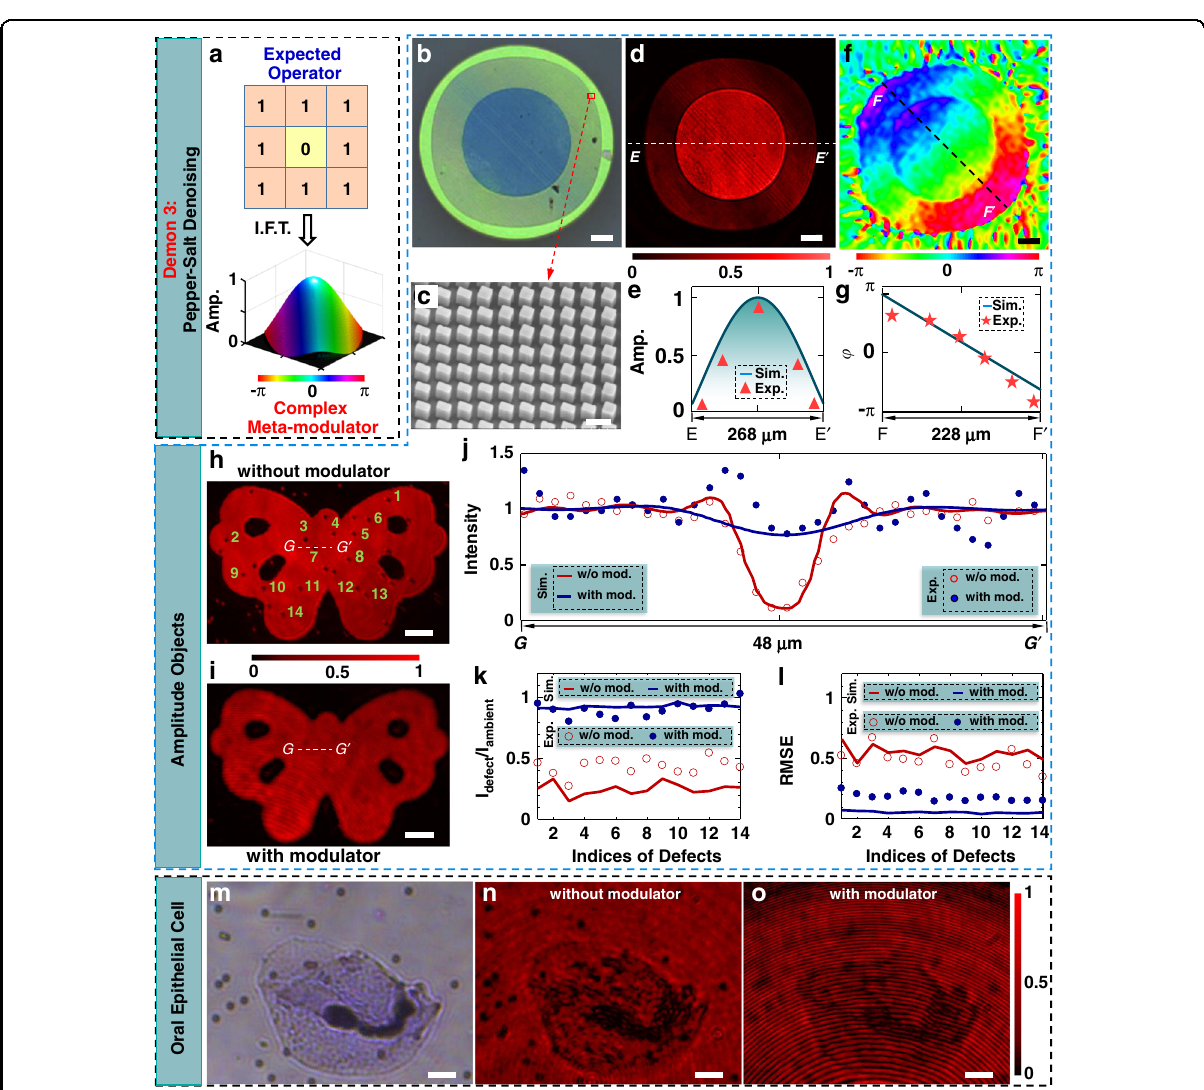
Fig. 4 Pepper-salt denoising. a Proposed operator (upper panel) and its corresponding meta-modulator for pepper-salt denoising. The size w 0 of every element in this operator is designed to be the size of defects. Thus, after processing by the meta-imager for salt denoising, the intensity pro fi les at the defects are taken as the averaged intensity at the surrounding positions, hereby removing the defects. b , c Microscopy ( b ) and SEM ( c ) images of our fabricated meta-modulator for pepper-salt denoising. Scale bars: 20 μ m in ( b ); 300 nm in ( c ). d Transmitted (cross-polarized part) pattern of the meta-modulator under the circular-polarization illumination. Scale bar: 20 μ m. e Simulated (curve) and experimental (triangles) line-scanning amplitude pro fi les along the line EE ′ (denoted in ( d )). The experimental amplitude is obtained by using a square root of the transmission in ( d ). f Retrieved phase pro fi les from the experimental interference patterns. Scale bar: 20 μ m. g Simulated (curve) and experimental (stars) phase pro fi les along the line DD ′ (denoted in ( f )). h Transmitted pattern of a binary-amplitude butter fl y (made in an opaque chromium fi lm on a quartz substrate) that is captured by using a single metalens without the modulator. Some of the defects are indexed as examples in the following characterizations. Scale bar: 20 μ m. i Processed an image of a butter fl y that is located at the input plane of our denoising meta-imager. Scale bar: 20 μ m. j Normalized intensity pro fi les along the line GG ′ (sketched in ( h , i )). Each intensity pro fi le is normalized to the averaged intensity outside the defect 7. k , l Simulated (curves) and experimental (dots and circles) intensity ratios ( k ) and RMSEs ( l ) at 14 exempli fi ed defects. The data before (w/o mod.) and after (with mod.) using the meta-modulator is compared in detail to observe the improved uniformity. Without introducing the error, we only examine the uniformity of intensity at a defect-centered square of 12 μ m × 12 μ m (i.e., the ef fi cient area of the operator). In k , the averaged intensity at the defect region (i.e., 4 μ m × 4 μ m) is labeled as I defect , while the averaged intensity at the left region of the square is calculated as I ambient . m Microscopic image of an oral epithelial cell with random defects. The defects have a size of ~2 μ m × 2 μ m. Scale bar: 10 μ m. n A 2.4-fold magni fi ed pattern of the oral epithelial cell. The magni fi ed defects have the size of 4.8 μ m × 4.8 μ m and work immediately as the input of our denoising meta- imager. Scale bar: 24 μ m. o Processed image by using our meta-imager. Scale bar: 24 μ